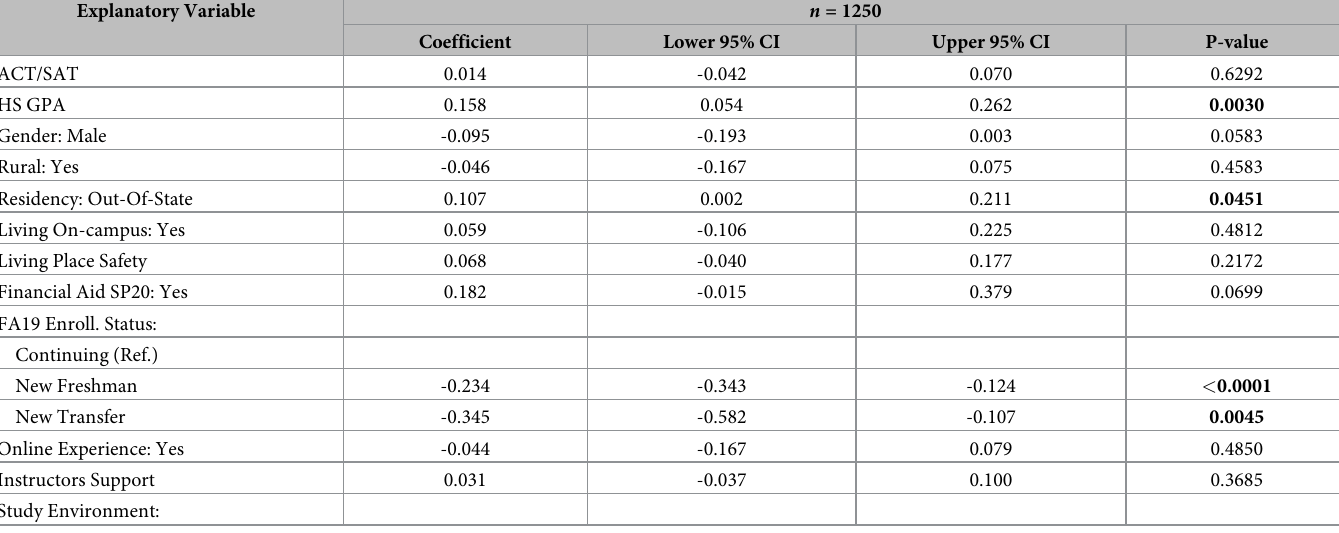
Table 6. Regression analysis results aggregated over m = 100 completed (imputed)